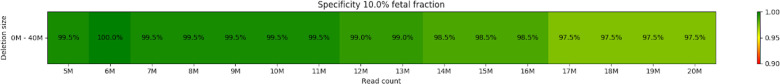
Specificity of the prediction for different read count and microdeletion size.Fetal fraction was set to 10% for all samples.